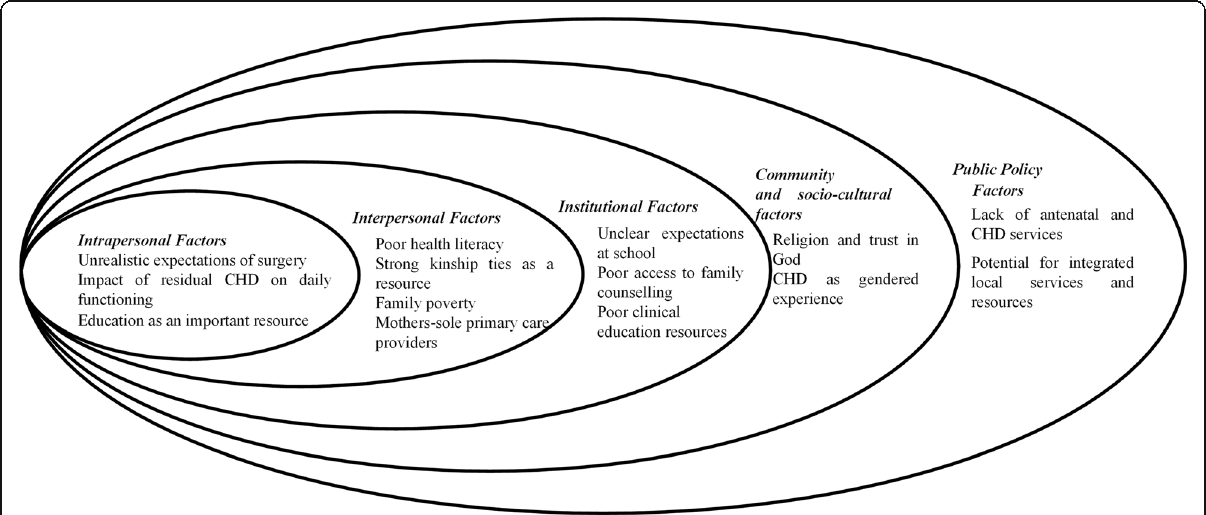
Fig. 1 Sociological model-Parental perspectives on the socio-cultural and environmental factors influencing the HRQOL of CHD surgical